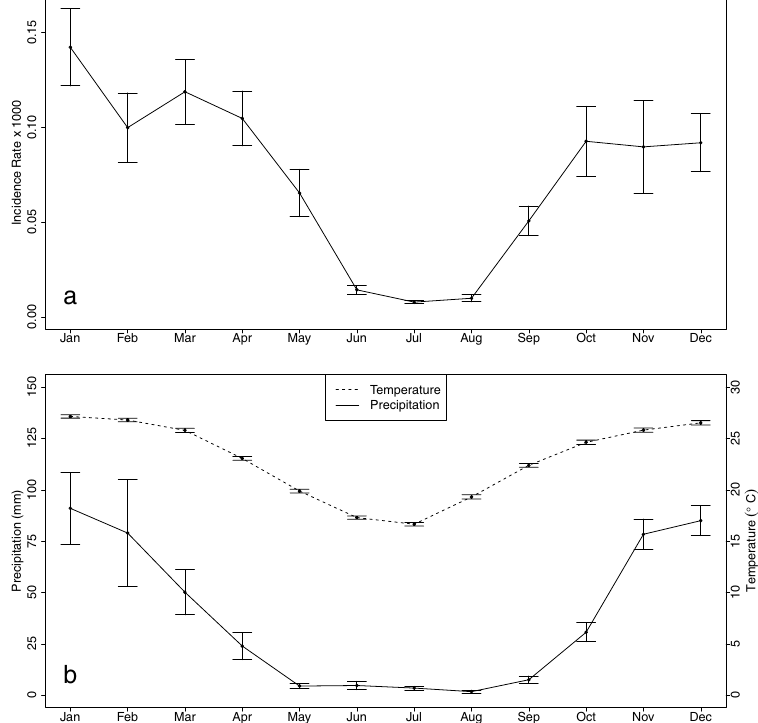
Figure 1. Monthly mean and standard deviation of ( a ) malaria incidence rate (% per 1000 person-years), ( b ) precipitation (solid line, mm month − 1 ), and mean temperature (dashed line, °C) in Limpopo for 1998 to 2014. Data were obtained from the spatially-averaged grid of Limpopo from CRU TS 3.23. Figure was made in R version 3.2.2